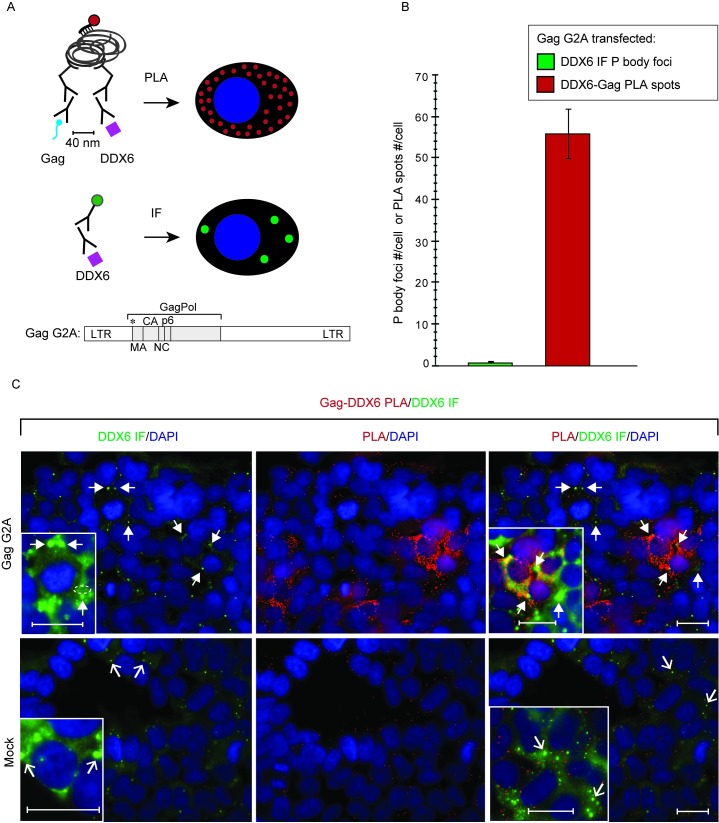
Complexes containing DDX6 colocalized with Gag G2A are far more numerous than DDX6-containing P bodies.(A) Gag-DDX6 PLA was used to identify regions in which Gag is within 40 nm from DDX6 in situ, with concurrent αDDX6 IF for quantification of P body foci. An experimental schematic for PLA methods is shown (see text for details). 293T cells were transfected with the indicated G2A provirus (Set 1 constructs in Fig 1A) or mock transfected. (B) The average number of P body foci per cell (green bar) or PLA spots per cell (red bar) was determined for all Gag-positive cells in five randomly chosen fields. (C) Representative images. From left to right for Gag G2A and Mock: DDX6 IF to detect P body foci (green) overlaid with nuclei (blue), PLA signal (red) overlaid with nuclei (blue), and a merge of all three. Insets in DDX6 IF panels in the first column show higher gain/higher magnification versions of cells above the insets, with specific P bodies indicated by arrows at different angles to allow P bodies in insets to be matched to P bodies in low power fields. The dotted oval shows an example of three small granular foci that are too small to be P bodies (i.e. not visible in low gain/low power image), but are visible as discrete small foci when gain and magnification are increased. Insets in merged panels show higher gain/higher magnification versions of cells to the right, with specific P bodies indicated by arrows at different angles to allow P bodies in inset to be matched to P bodies in low power fields. Scale bar, 5 μm. Data are representative of three independent replicate experiments. Error bars show SEM (n = 5 fields).